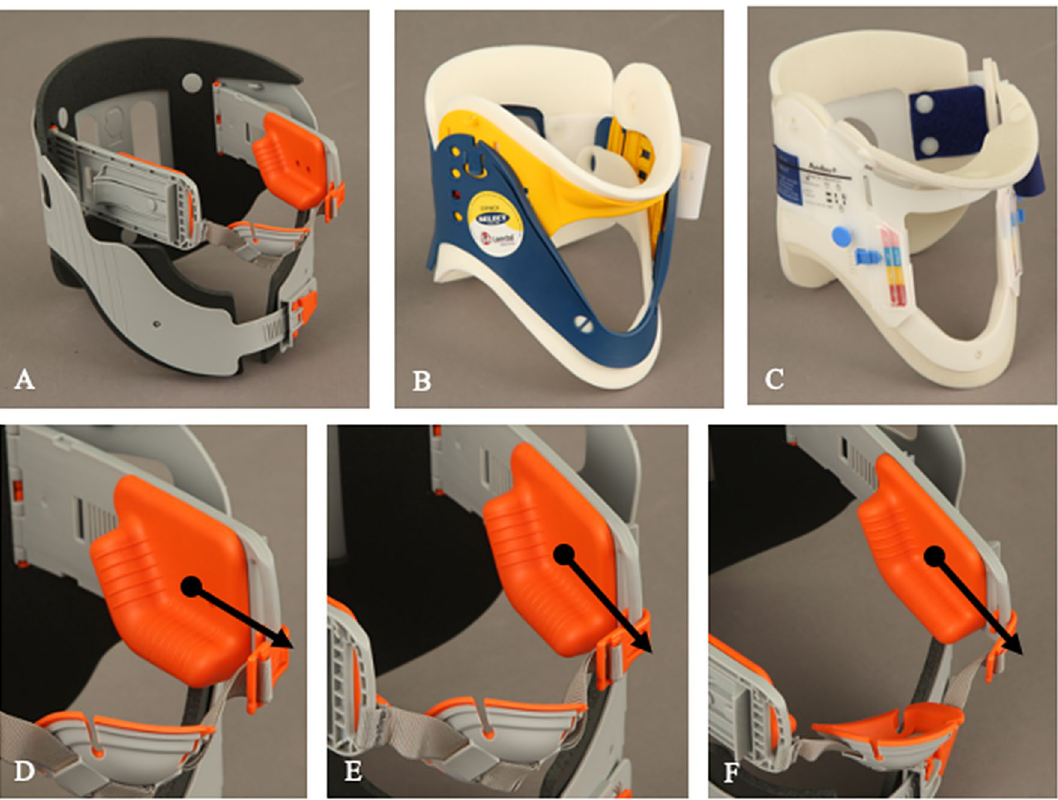
Figure 1. In the present study, three different cervical collars were tested on fresh human cadavers: Weinmann Lubo Airway Collar ( A ), Laerdal Stifneck ( B ) and Ambu Perfit ACE ( C ). Shown is the innovative mechanism ( D , E , F ). The red angle (black dot) pushes the mandible ventrally (black arrow) for opening the upper